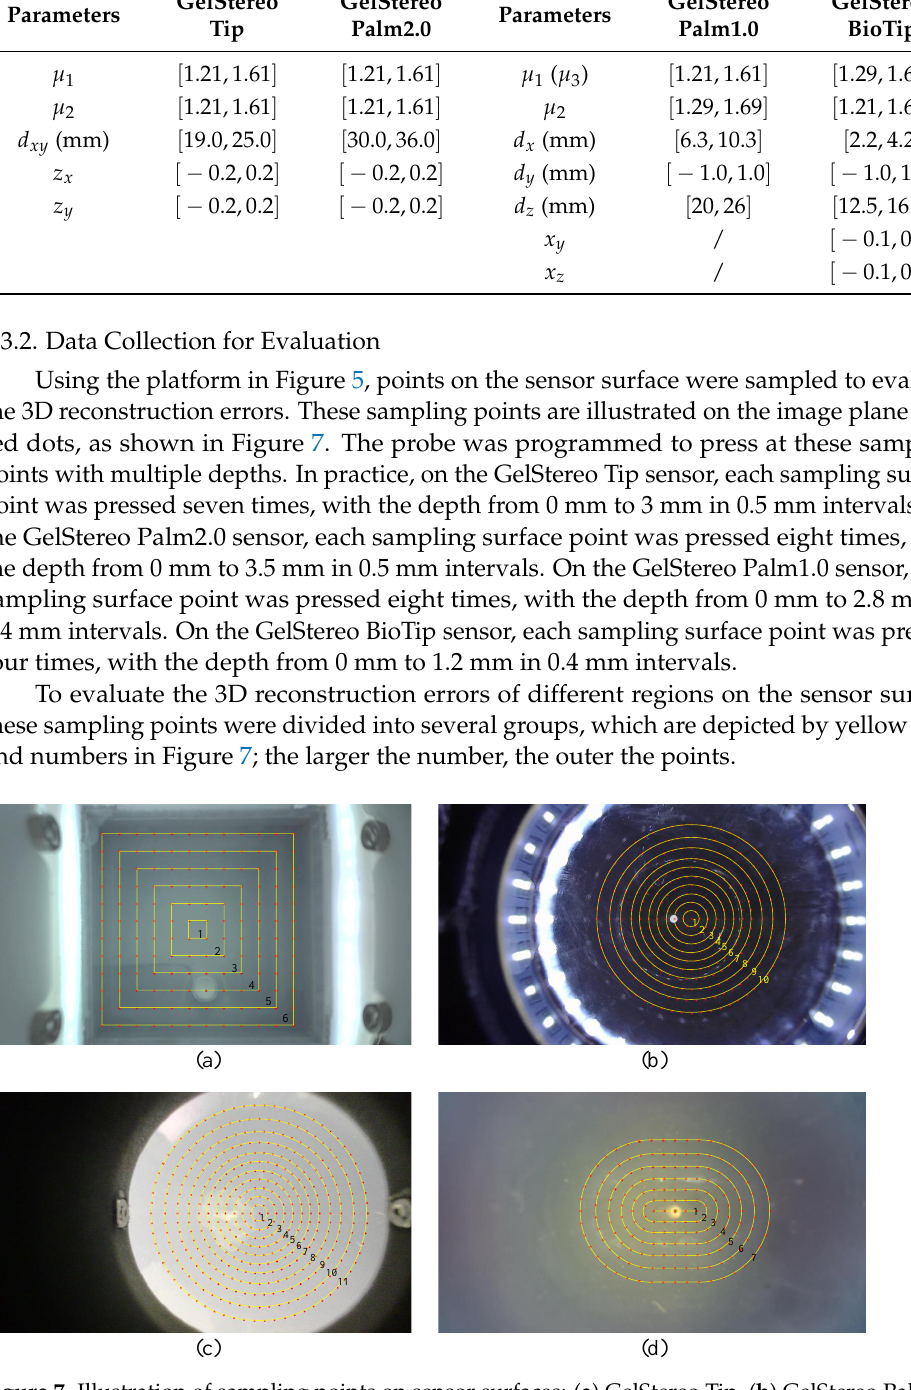
Figure 7. Illustration of sampling points on sensor surfaces: ( a ) GelStereo Tip, ( b ) GelStereo Palm2.0, ( c ) GelStereo Palm1.0, ( d ) GelStereo BioTip